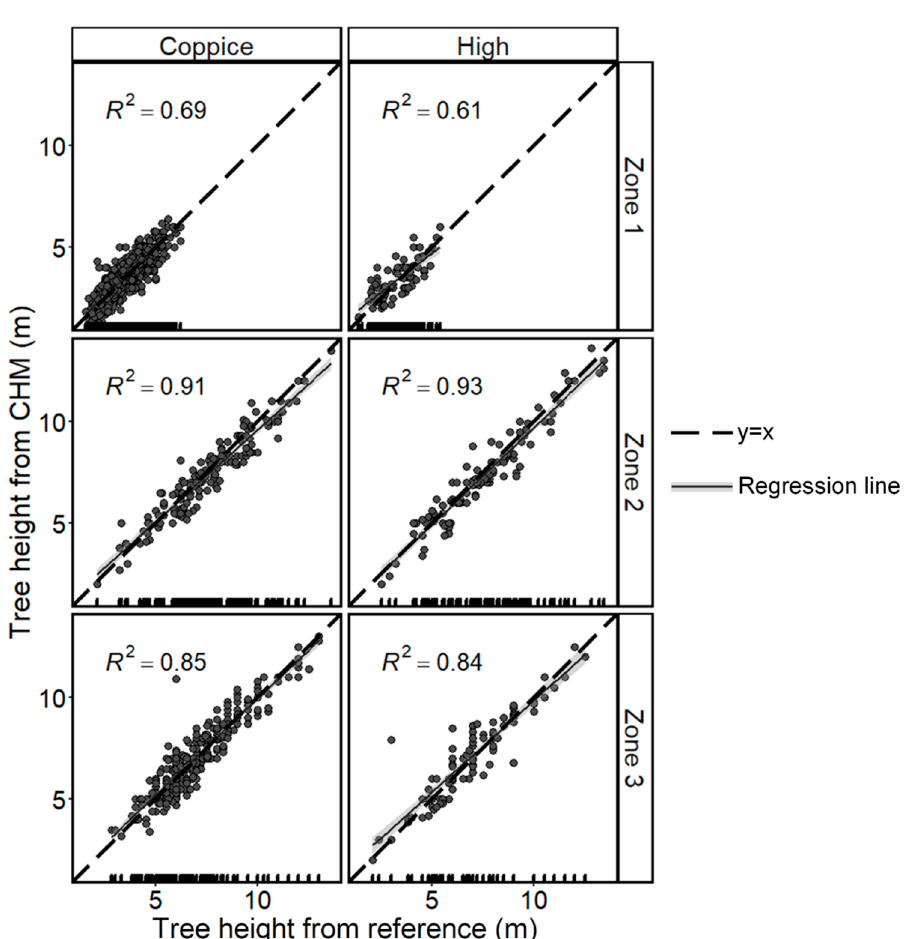
Figure 4. Comparison of H from CHM with actual measured values (reference values).